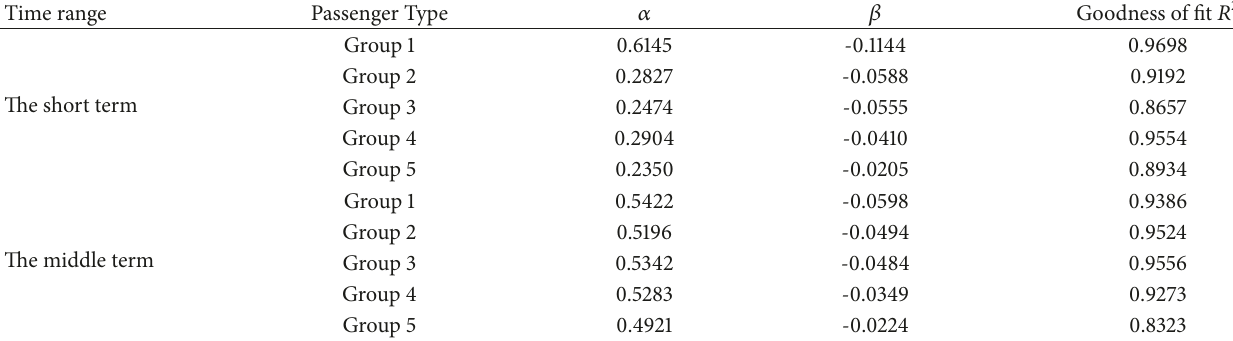
Table 9: Fitting results of retiming elasticity for different types of